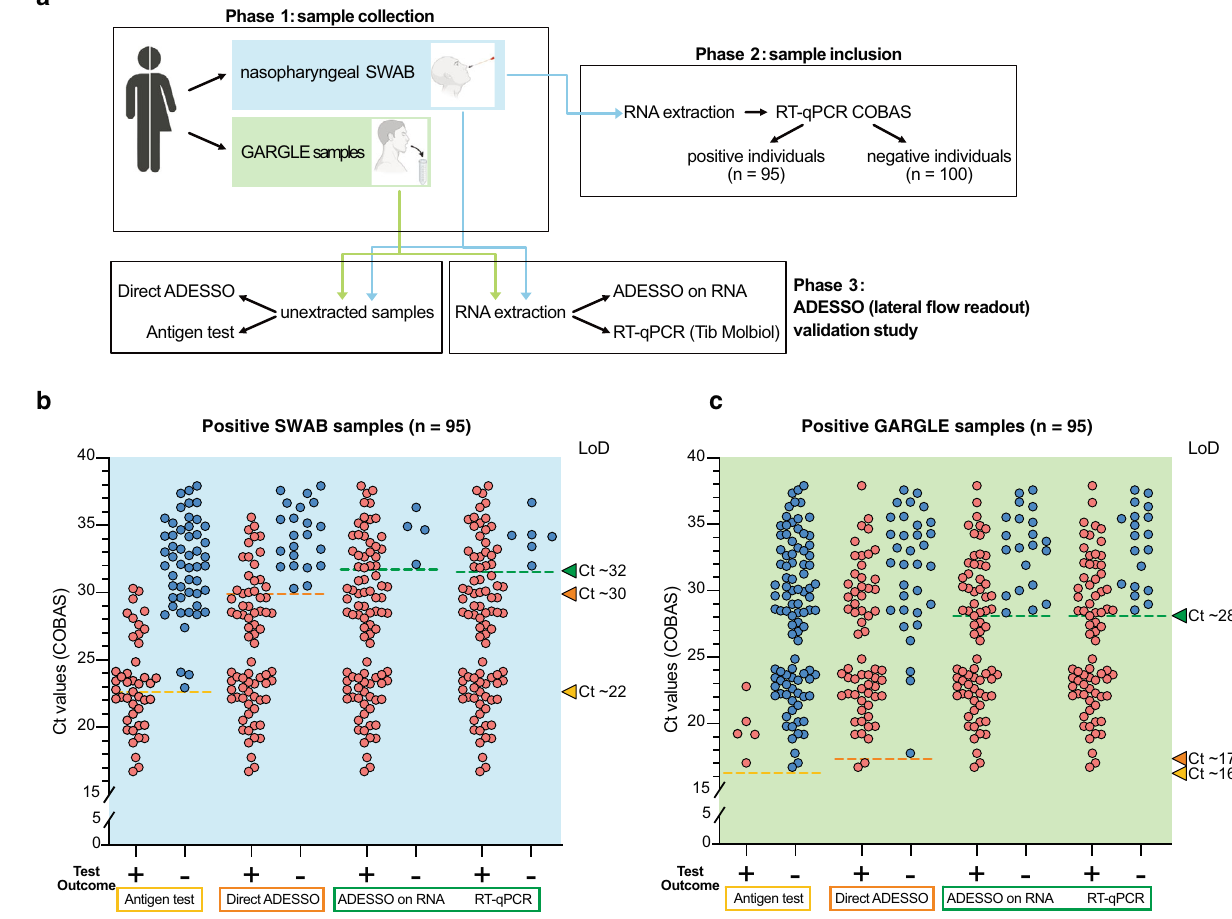
Fig. 2 Evaluation of ADESSO performance on clinical samples in direct comparison to RT-qPCR and antigen test. a Schematic of the validation study to assess ADESSO performance for SARS-CoV-2 detection in clinical samples in comparison with RT-qPCR (Tib Molbiol) and antigen test (RIDA QUICK SARS-CoV-2 Antigen). The COVID-19 status of the samples included in the study was initially determined by RT-qPCR (COBAS). ADESSO was performed on both extracted RNA and unextracted samples with lateral fl ow readout. b , c SARS-CoV-2 detection and LoD evaluation in swab ( b ) and gargle ( c ) samples collected from 95 COVID-19 positive individuals using RIDA QUICK SARS-CoV-2 Antigen test, ADESSO and Tib Molbiol RT-qPCR. Each sample is represented by a red or blue dot for positive or negative test outcome, respectively. “ Direct ” ADESSO and RIDA QUICK SARS-CoV-2 Antigen tests were performed on unextracted samples, while ADESSO and Tib Molbiol RT-qPCR were performed on extracted RNA. The LoD for each test is represented as a dotted line and the corresponding Ct value is indicated by an arrowhead on the right Y